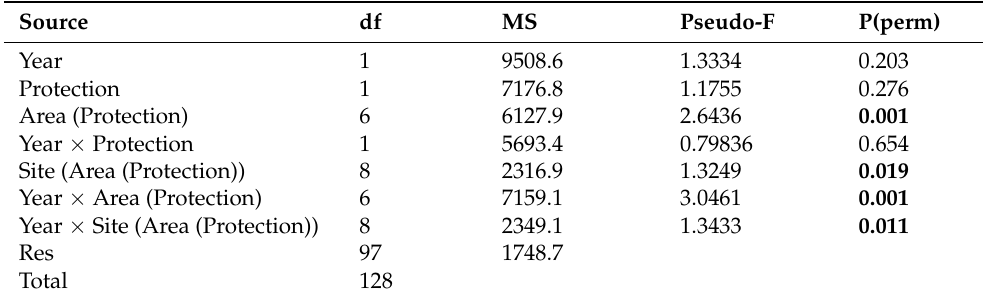
Table 1. Results of the four-factor PERMANOVA test considering the “Year” (2 levels, fixed), “Protection” (2 levels, fixed), “Area” (8 levels, random and nested in “Protection”), and “Site” (2 levels, random and nested in “Area”) factors for the analysis of the abundance (nº/m 2 ) of non-cryptic fishes in the northern marine PNSACV. Bold values highlight significant effects and interactions ( p < 0.05). Source df MS Pseudo-F